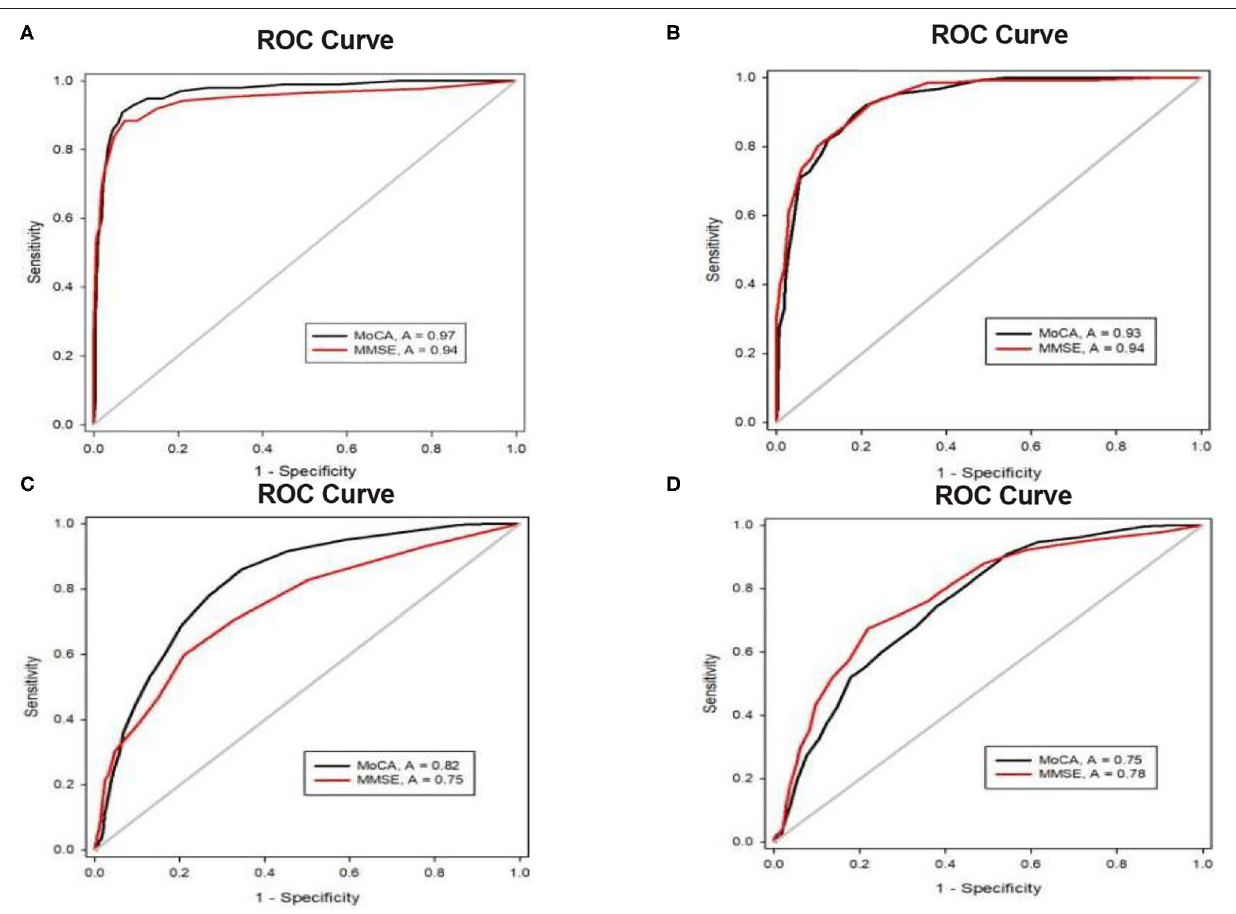
FIGURE 2 | (A) ROC curves for the MoCA and MMSE for the detection of dementia in the elders < 75 years. (B) ROC curves for the MoCA and MMSE for the detection of dementia in the elders ≥ 75 years. (C) ROC curves for the MoCA and MMSE for the detection of MCI in the elders < 75 years. (D) ROC curves for the MoCA and MMSE for the detection of MCI in the elders ≥ 75